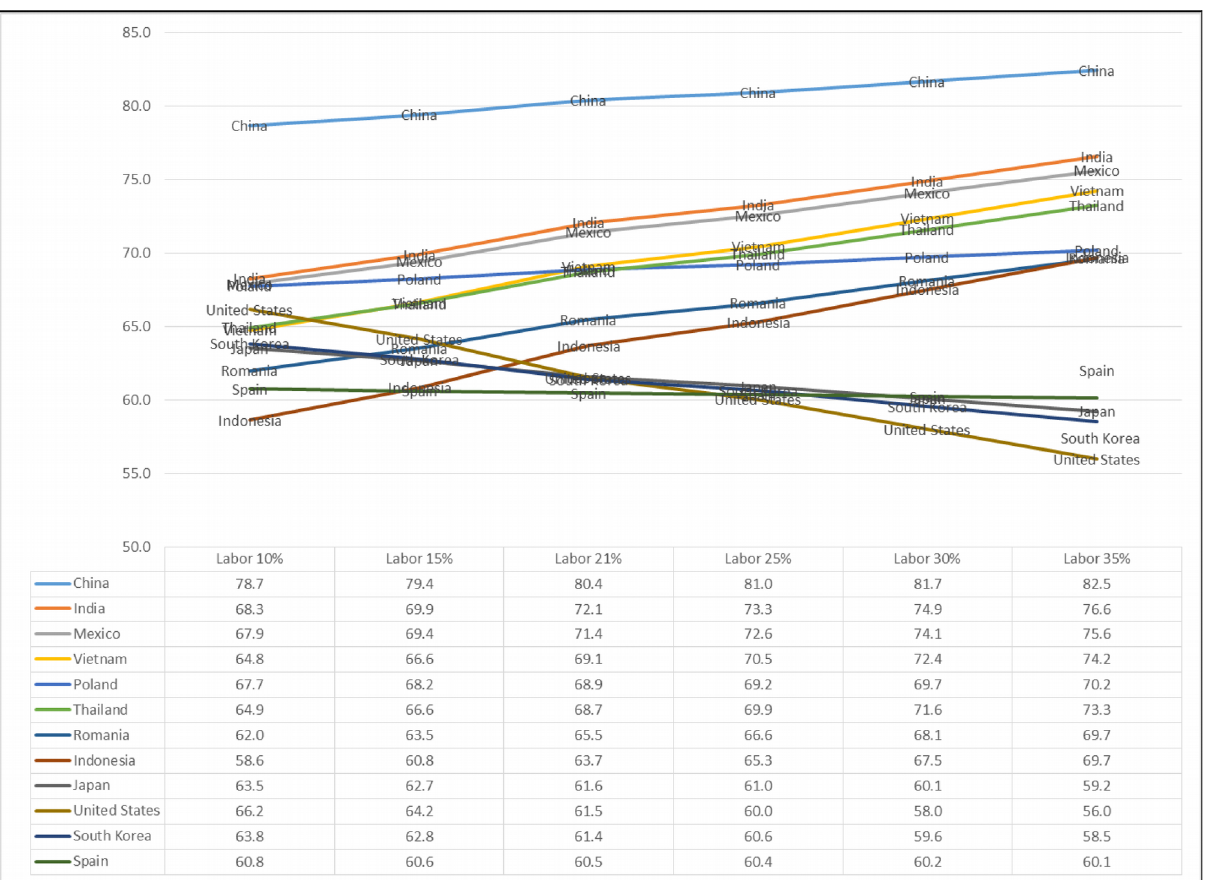
Figure 5. Labor rate utility weight